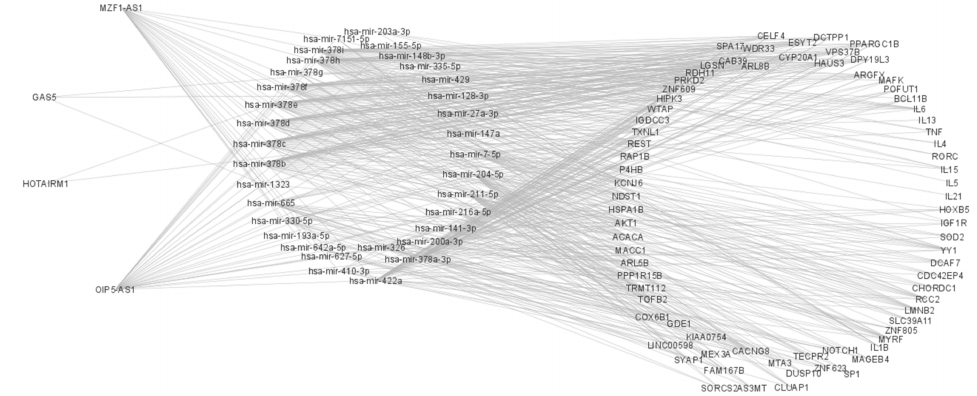
Figure 4. Interaction network of the lncRNAs studied in a lncRNAs-miRNAs-Genes network that could interact through base-pairing interaction. The analysis of networks was performed using the miRNET 2.0 bioinformatics tool and visualization was achieved through Cytoscape